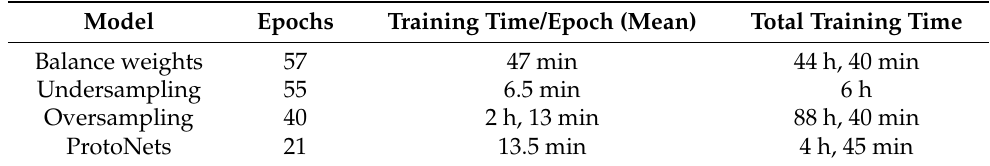
Table 5. Training time for the best model of each method. Model